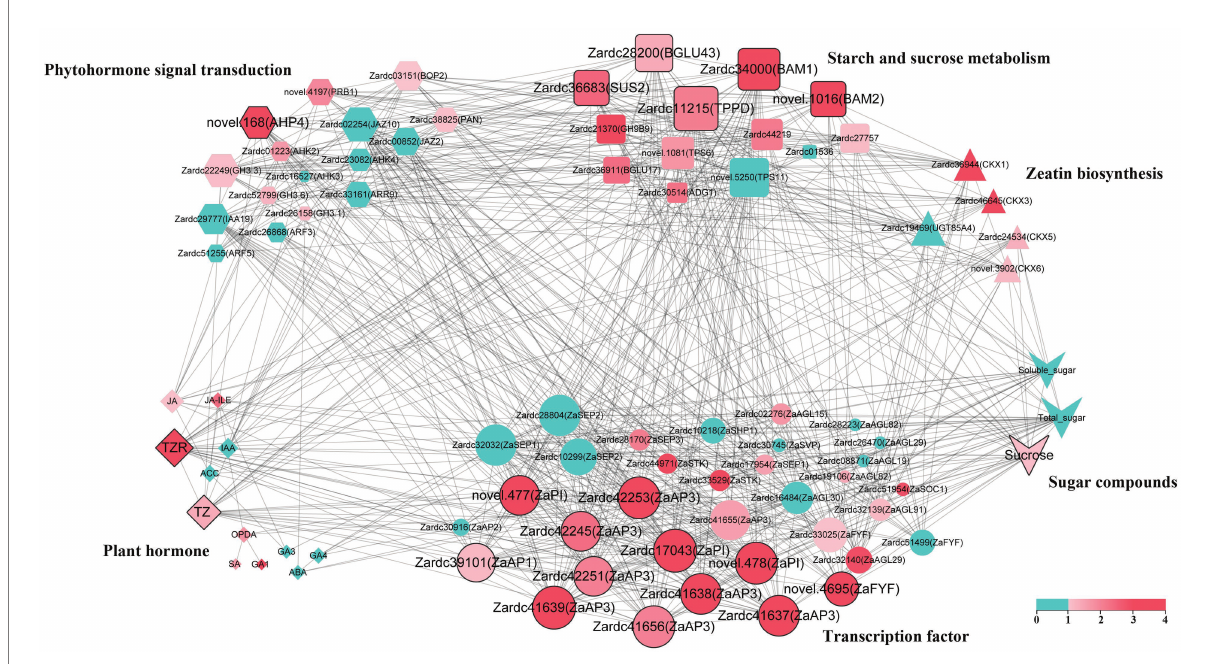
FIGURE 7 The co-expression network reveals the key genes involved in floral sex differentiation. The color of each bubble indicated the root mean square of log2(foldchange) among M3 vs. F3 and M4 vs. F4, and the size of bubble was the degree of each factor. The hub factors were highlighted with thick edging, which were identified by the top 40% of their degrees coupled with their